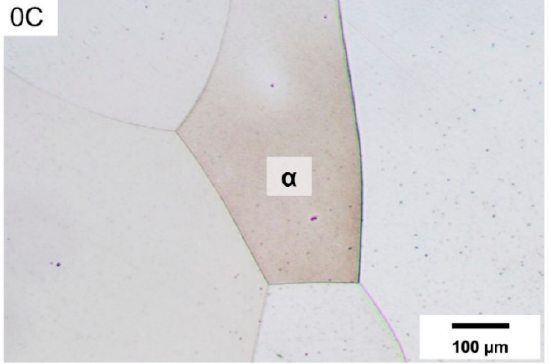
Figure 2. Optical micrograph of the 0C alloy quenched to 20 °C and etched with Beraha I solution. By adding 0.1% C to the binary alloy, the austenite range expanded and it became possible to obtain a noticeable fraction of martensite at RT. The latter was confirmed by the microstructural examination of as-quenched specimens, as discussed in Section 3.3. Accordingly, the weak exothermic peaks, marked by diamond symbols in Figure 1a